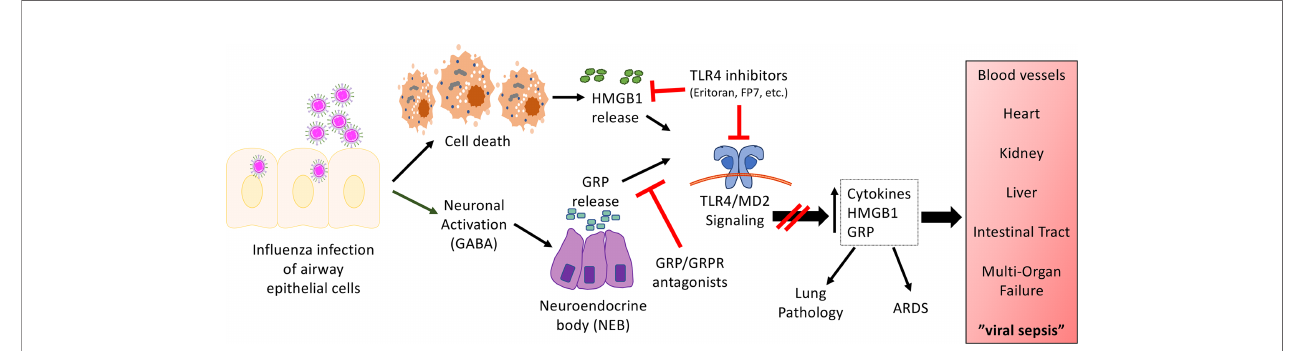
FIGURE 1 | Hypothetical model for the involvement of TLR4 in in fl uenza-induced disease. Our model proposes that in fl uenza infects airway epithelial cells, leading to cell death and the release of DAMPs such as HMGB1. In turn, HMGB1 binds to the TLR4/MD2 complex to initiate signaling leading to release of cytokines and additional DAMPs. In addition, virus infection activates neurons in close proximity to NEBs, leading to the release of GRP. GRP has been shown to synergize with TLR4 agonists (82). Blocking either TLR4/MD2, HMGB1, or GRP mitigates in fl uenza-induced ALI and disease pathogenesis. We hypothesize that this same mechanism is operative for other respiratory